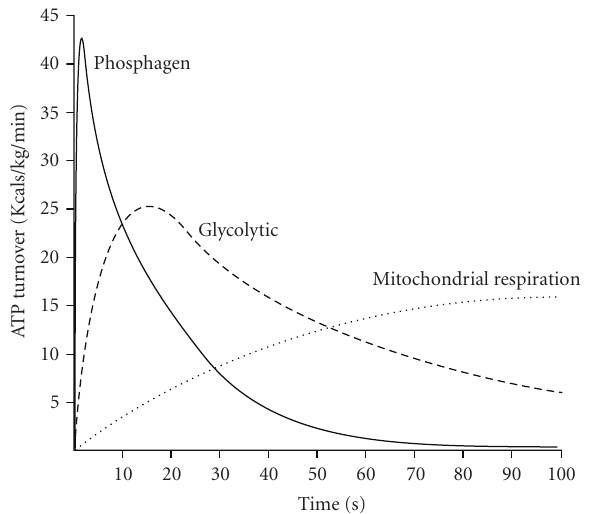
Figure 9: Energy system interaction and the di ff erences in rates of ATP turnover during short term intense exercise to fatigue. The data presented is original, theoretical, and based on the authors’ assessment of contemporary research evidence.